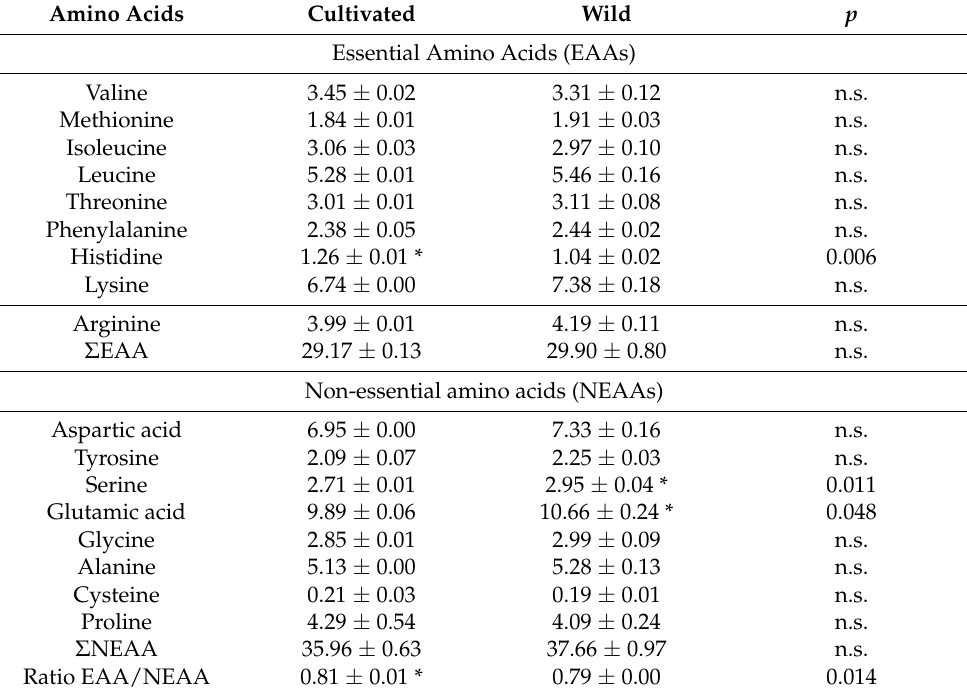
Table 5. Muscle amino acid profile (g 100 g muscle − 1 DW) of wild and cultivated thick-lipped grey mullets.